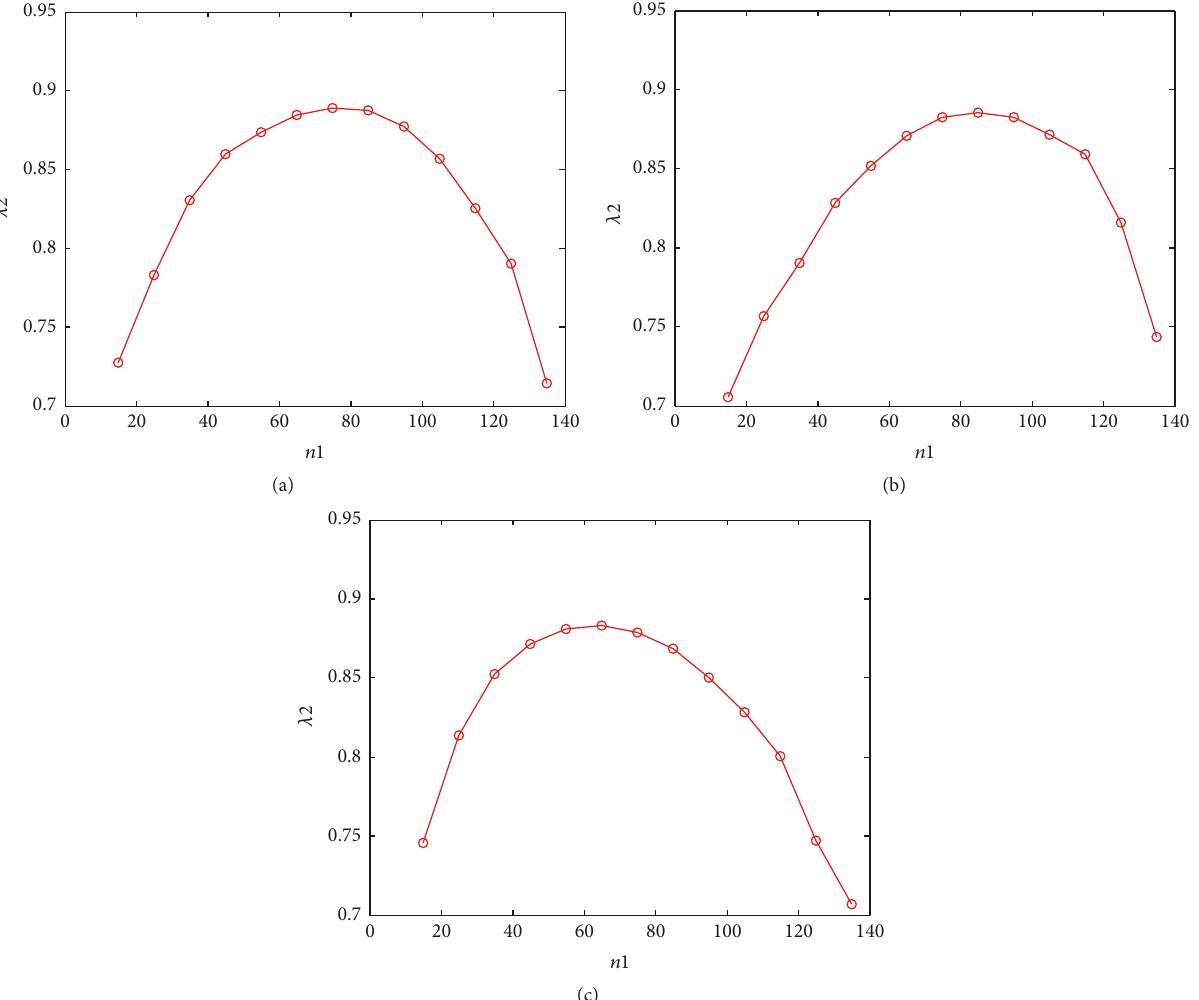
= 0.02 , in (a), 𝑝 = 𝑝 = 0.2 ; in (b), 𝑝 = 0.2 , 𝑝 = 0.4 ; 3 1 2 1 2